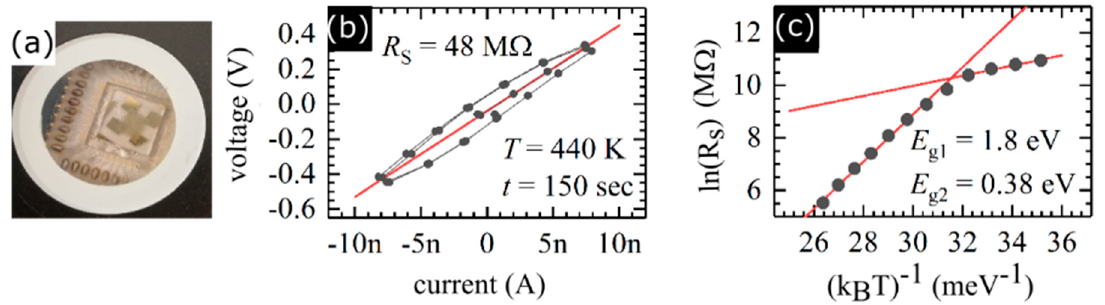
Figure 3. ( a ) Photography of device used for electric measurements, ( b ) I–V characteristic obtained for 440 K, t = 150 s is waiting time before collecting results, the red solid line represents linear fitting performed for the resistance evaluation (slope) ( c ) Arrhenius dependence with extracted bandgap value.